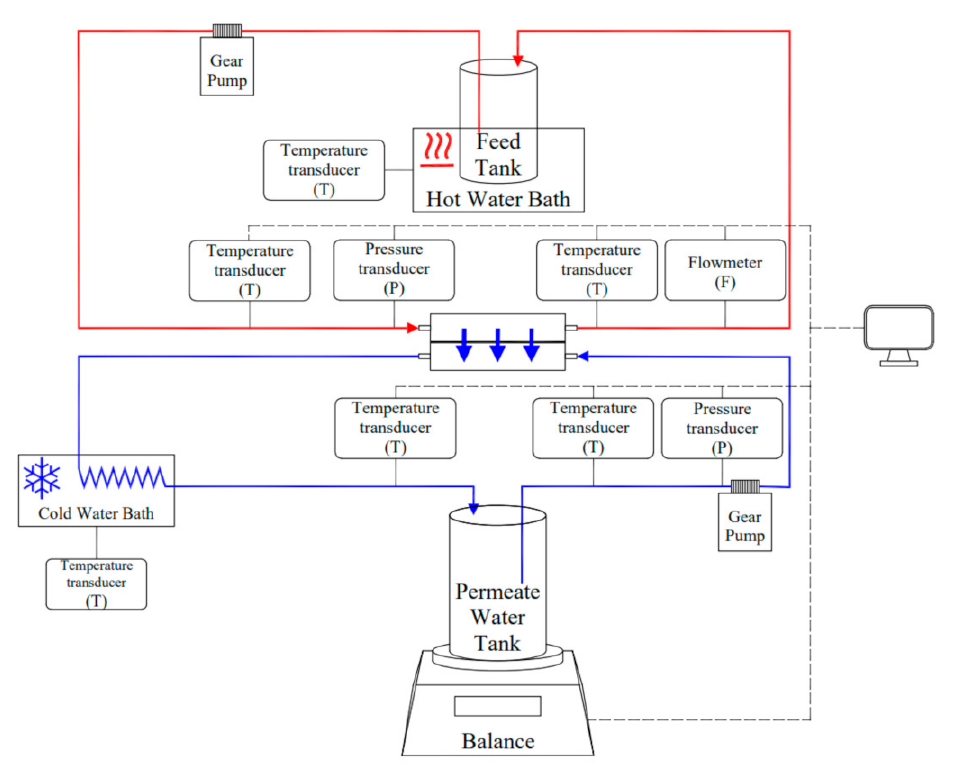
Figure 2. Schematic diagram of the membrane distillation experiment